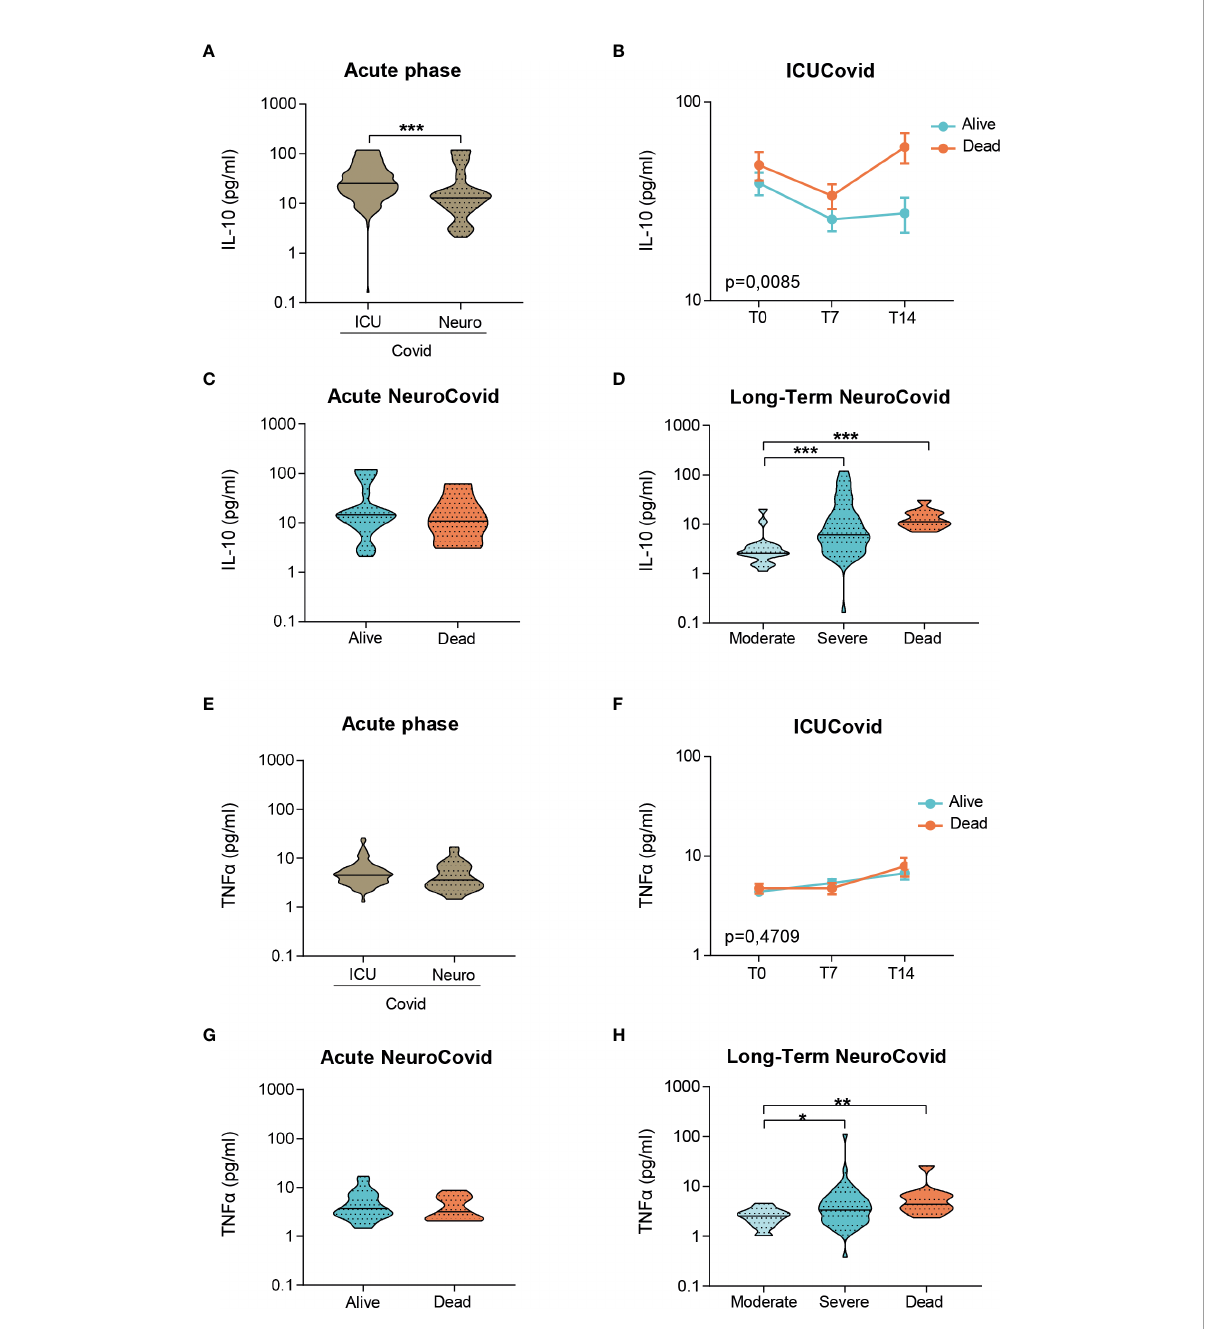
FIGURE 5 IL-10 and TNF a in plasma of two cohorts of COVID-19 patients. (A-H) IL-10 (A-D) and TNF a (E-H) concentrations were measured by Simoa technology in plasma from two cohorts of COVID-19 patients. (A, E) Violin plots of IL-10 (A) and TNF a (E) in the acute phase, in ICUCovid (n=79) and NeuroCovid samples (n=31). (A) Mann Whitney, ***p<0.001. (E) Mann Whitney, p=0.085. (B, F) IL-10 (B) and TNF a (F) were measured in ICUCovid patients at ICU admission (T0) and after 7 (T7) and 14 days (T14). ICUCovid patients were strati fi ed as alive (n=32) or dead (n=14). Data (mean ± SEM) indicate biomarker concentrations. (B) Two-way ANOVA for repeated measures, p<0.01 for cohort factor; **p < 0.005 alive versus dead at T14 by Sidak ’ s post hoc test. (F) Two-way ANOVA for repeated measures, p = 0.4709. (C, G) IL-10 (C) and TNF a (G) were measured in the acute phase in samples from NeuroCovid patients, strati fi ed as alive (n=23) or dead (n=8). (C) Mann Whitney, p=0.6652; (G) Mann Whitney, p=0.5498. (D, H) The concentrations of IL-10 (D) and TNF a (H) at a longer time, in samples from NeuroCovid patients, strati fi ed as moderate (n=18), severe (n=42) or dead (n=8). (D) Kruskal-Wallis, p< 0.0001; ***p < 0.001 by Kruskal-Wallis, Dunn ’ s post hoc test. (H) Kruskal-Wallis, p<0.01; *p < 0.05, **p < 0.01 by Kruskal-Wallis, Dunn ’ s post hoc